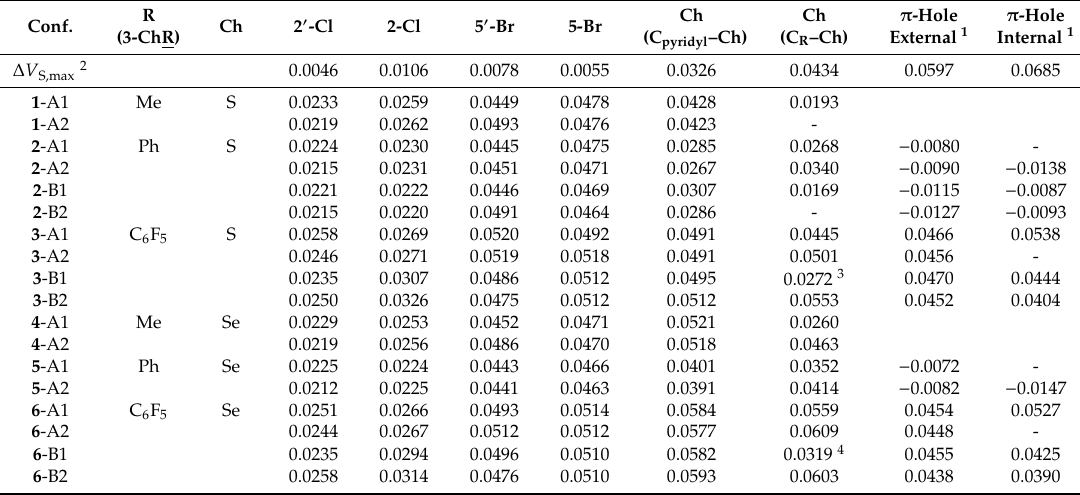
Table 1. V S,max (au) on halogen (Cl, Br), sulfur and selenium σ -holes (0.002 au), and the pentafluorophenyl ring π -hole calculated for conformers of compounds 1 – 6 (B3LYP / 6-311G*). Conf.